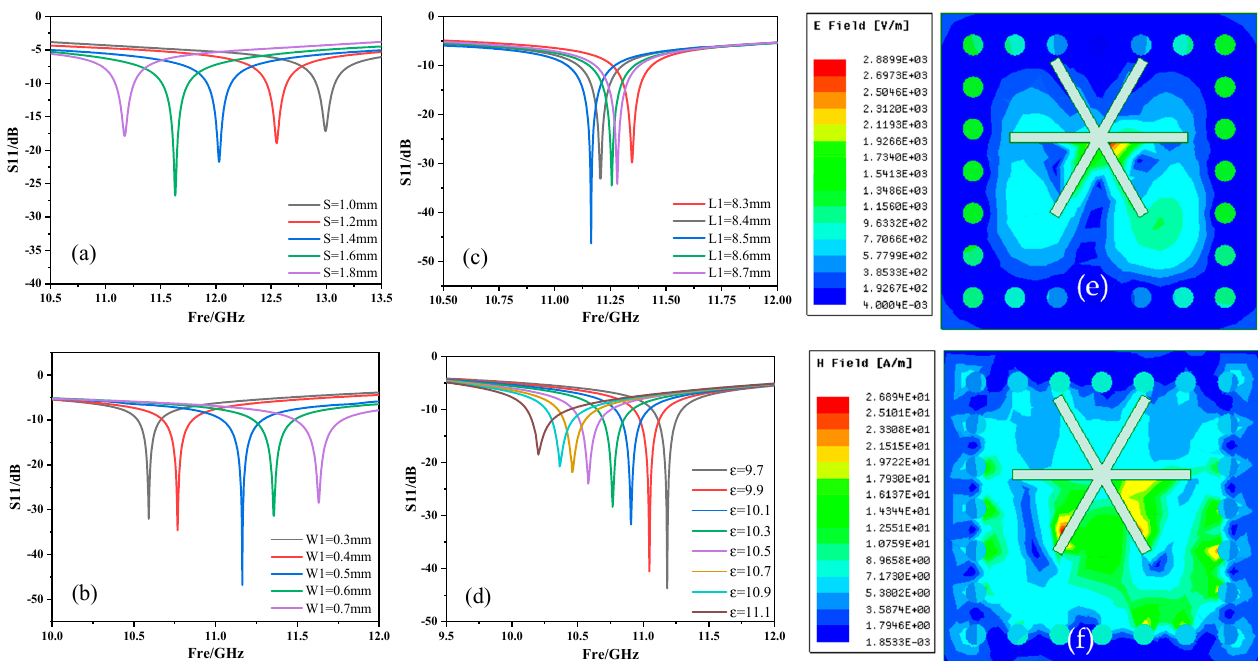
Figure 3. ( a – c ) The simulation results of the sensor structure parameters S, W1 and L1, ( d ) the simulation result of the sensor resonant frequency changing with the dielectric constant, ( e , f ) the electric and magnetic field distribution diagrams of the sensor after the simulation was completed.